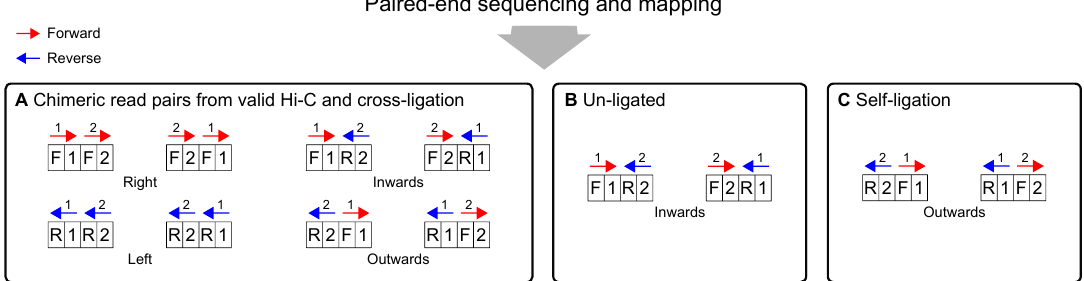
Figure 4. Only the two outermost ends of fragments are subjected to paired-end sequencing and mapped to the forward (red) and reverse strand (blue) of the corresponding reference genome. Read pairs arising from chimeric fragments may have all possible relative orientations ( A ). Read pairs arising from un-ligated fragments can only point inwards ( B ). Read pairs arising from self-ligation must point outwards ( C